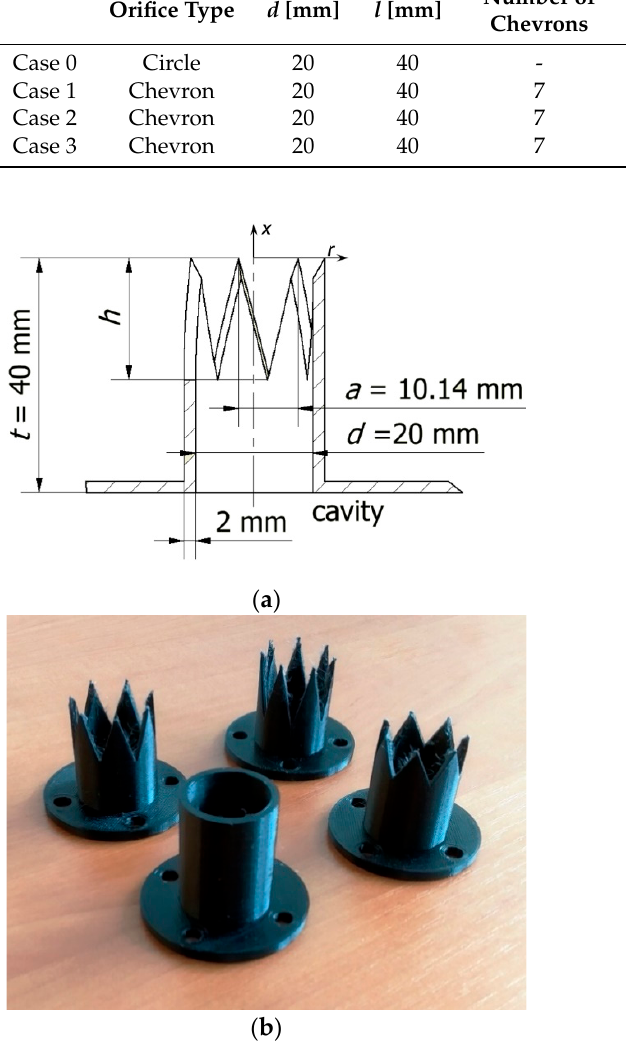
Figure 1. The parameters of the orifices ( a ) and the orifices printed using 3D technology before treatment ( b ). Table 1. Specification of the synthetic jet actuators (SJAs).